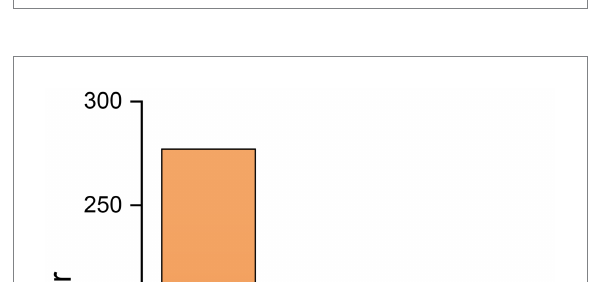
FIGURE 2 Evolution of publications and patent filings in the period 1970– 2022.